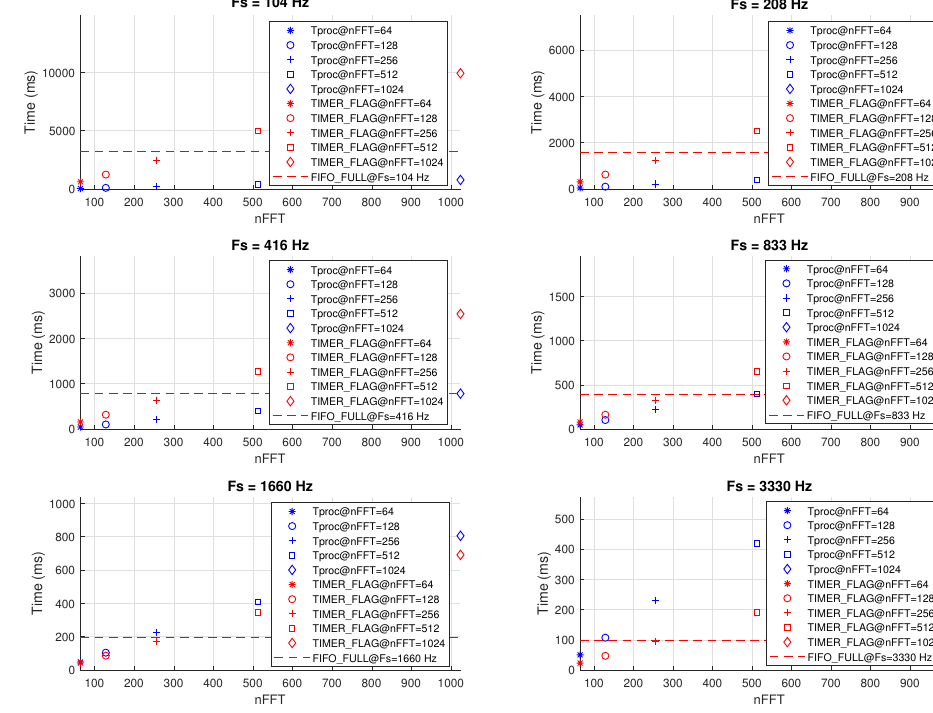
Figure 12. ST Performance measurements.